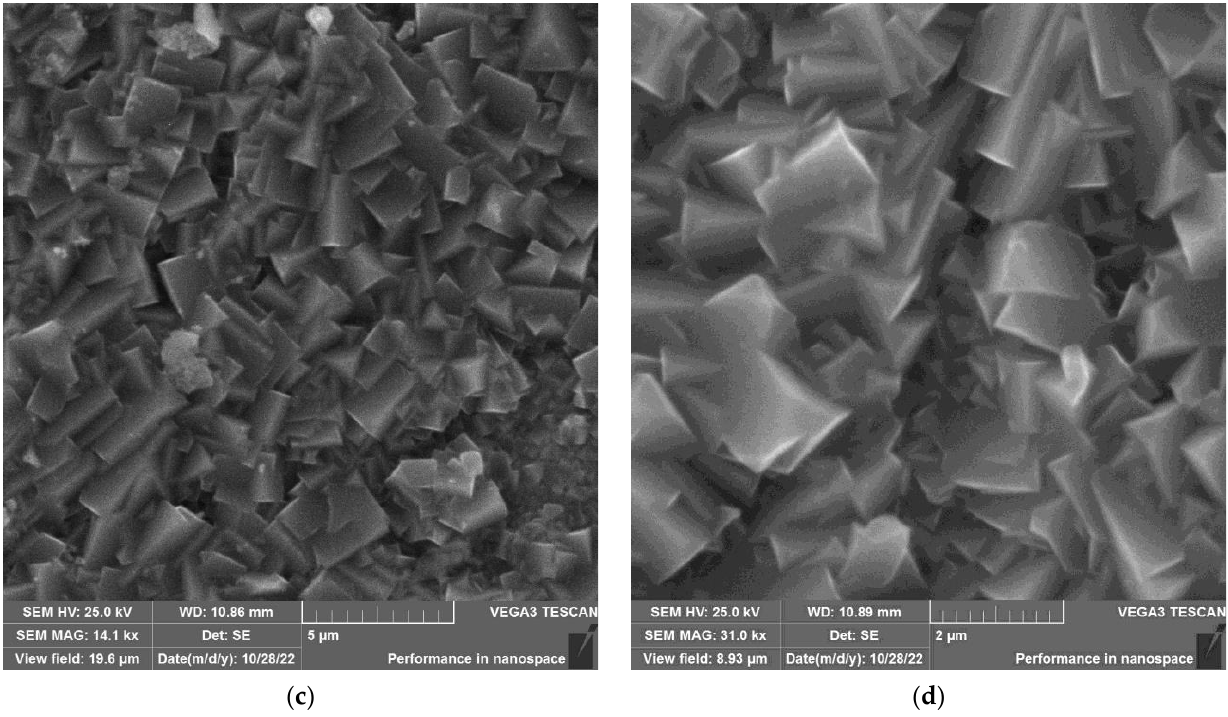
Figure 12. Surface of disk specimen № 11 (T irr = 550 °C, Table 4) at different magnifications after autoclave SCC tests with a load value of 356 N (before crack opening loading).